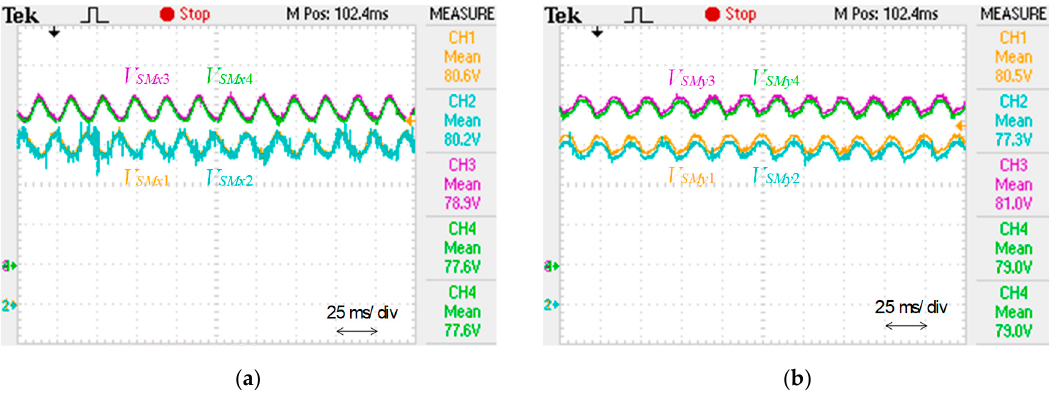
Figure 30. Experimental results (when one load section is loaded): ( a ) SM voltages of section x converter; ( b ) SM voltages of section y converter. SM DC voltage ( V SM : 20 V/div).